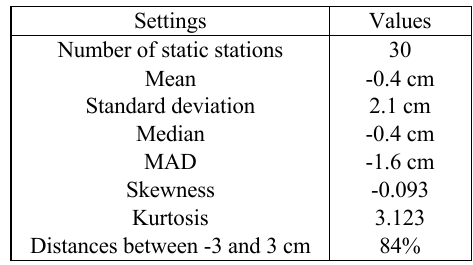
Table 2. Results of the comparison between point clouds (reference result)